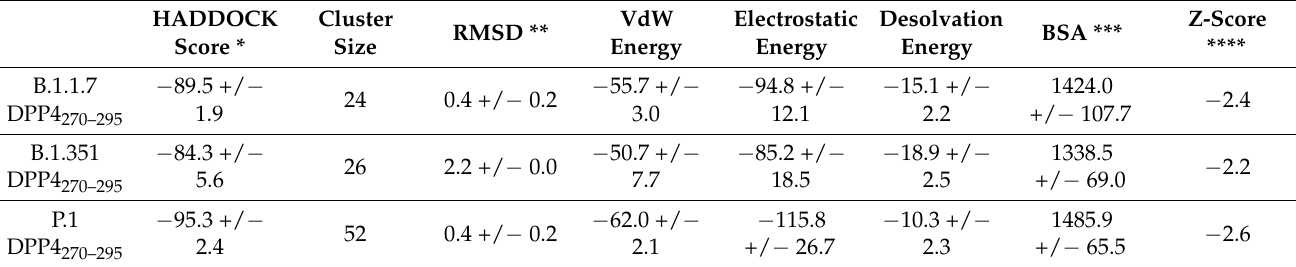
Table 4. Comparison between the cluster statistics of DPP4 270–295 in complex with B1.1.7, B1.351, and P.1 mutated complexes, after molecular recognition through the HADDOCK tool.